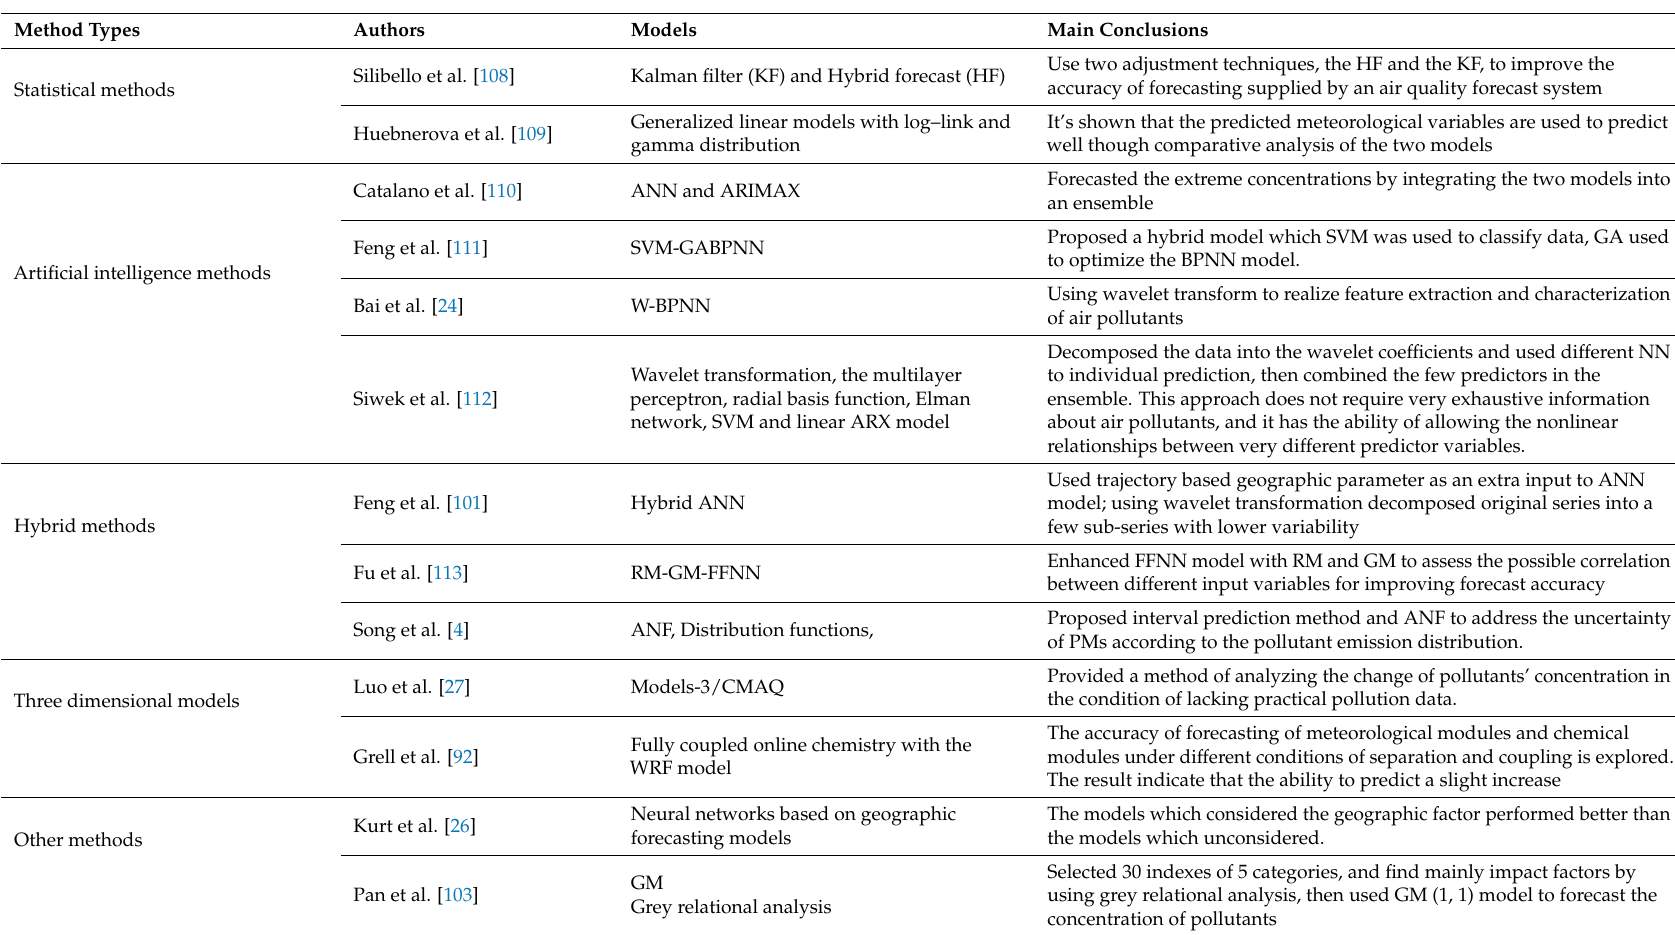
Table 23. Different models of air pollution